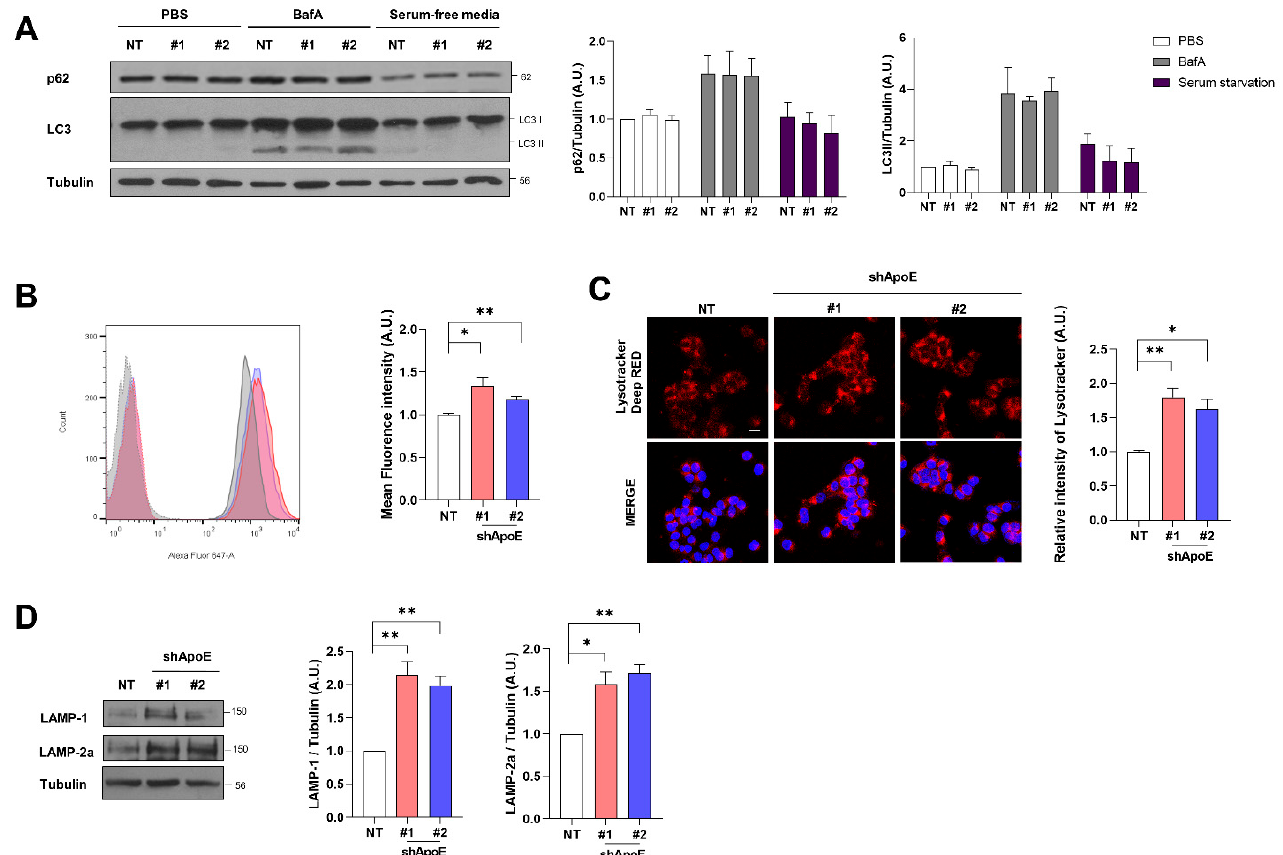
Figure 6. ApoE deficiency enhances chaperone-mediated autophagy in SH-SY5Y cells. ( A ) NT and ApoE KD #1, #2/A53T α -syn-EGFP OE SH-SY5Y cells were treated with 100 nM bafilomycin A1 for 24 h or cultured in serum-free media for 24 h. The cells were then lysed with RIPA buffer and samples were analyzed by Western blot. Values were derived from three independent experiments ( n = 3). ( B ) The cells were incubated with 50 nM lysotracker for 30 min and then analyzed by flow cytometry. Dotted lines indicate values from samples without lysotracker treatment. Values were derived from three independent experiments ( n = 3). ( C ) The cells were treated with 50 nM lysotracker for 30 min and their intensity was analyzed by confocal microscopy. Values were derived from three independent experiments ( n = 3). ( D ) The cells were lysed with RIPA buffer and analyzed by Western blot. Values were derived from three independent experiments ( n = 3). * p < 0.05, ** p < 0.01 against the control; one-way ANOVA. Blue indicates DAPI staining. Scale bar indicates 20 µ